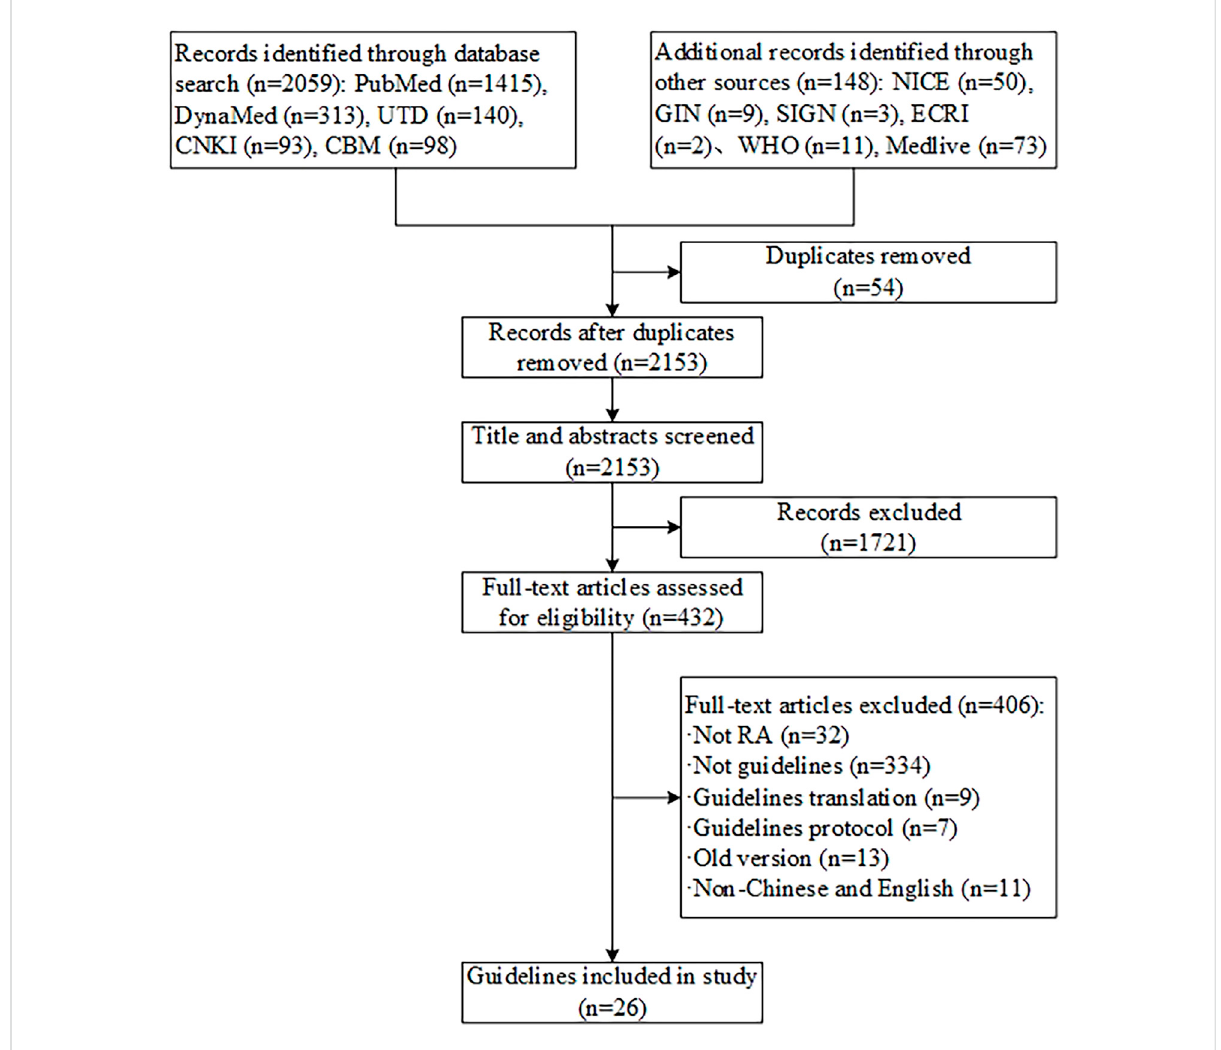
FIGURE 1 Flow diagram of the literature screening